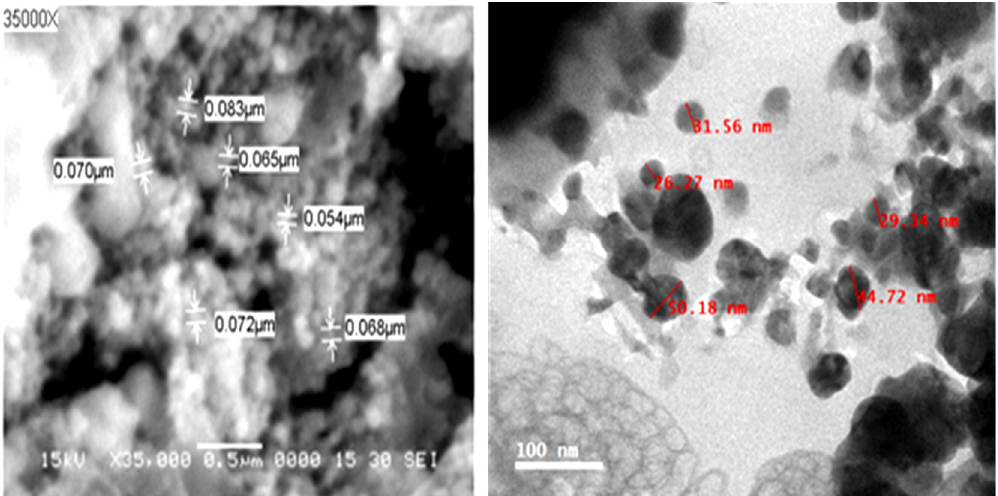
Figure 1. SEM ( left ) and TEM ( right ) images of silver nanoparticles biosynthesized by aqueous extract of O. basilicum as reducing agents. (Bar = 0.5 µm for SEM 100 nm for TEM).